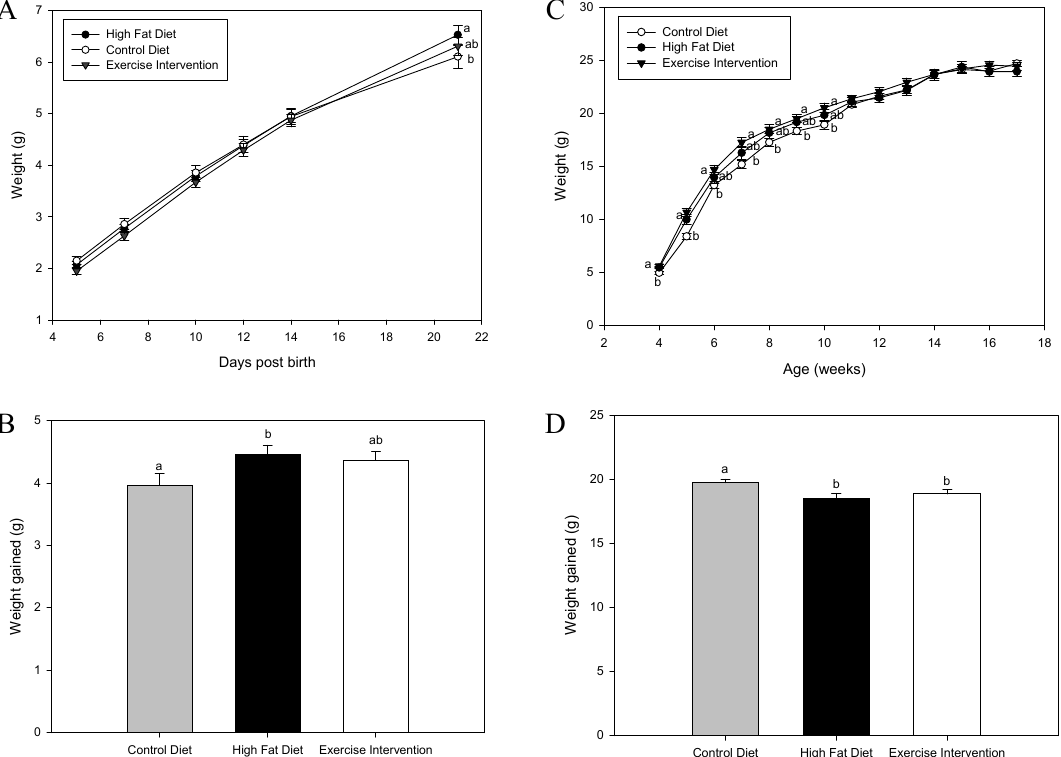
Figure 1. Effect of high fat diet fed founder diet and/or exercise interventions on male offspring pre-weaning and post-weaning weights. ( A ) Pre-weaning weights (day 5–day 21); ( B ) Total weight gained pre-weaning (day 5–day 21); ( C ) Post-weaning weights (4–17 weeks) and ( D ) total weight gained post-weaning (4–17 weeks). Data is expressed as mean ± standard error mean. a, b Different letters denote significance at p <